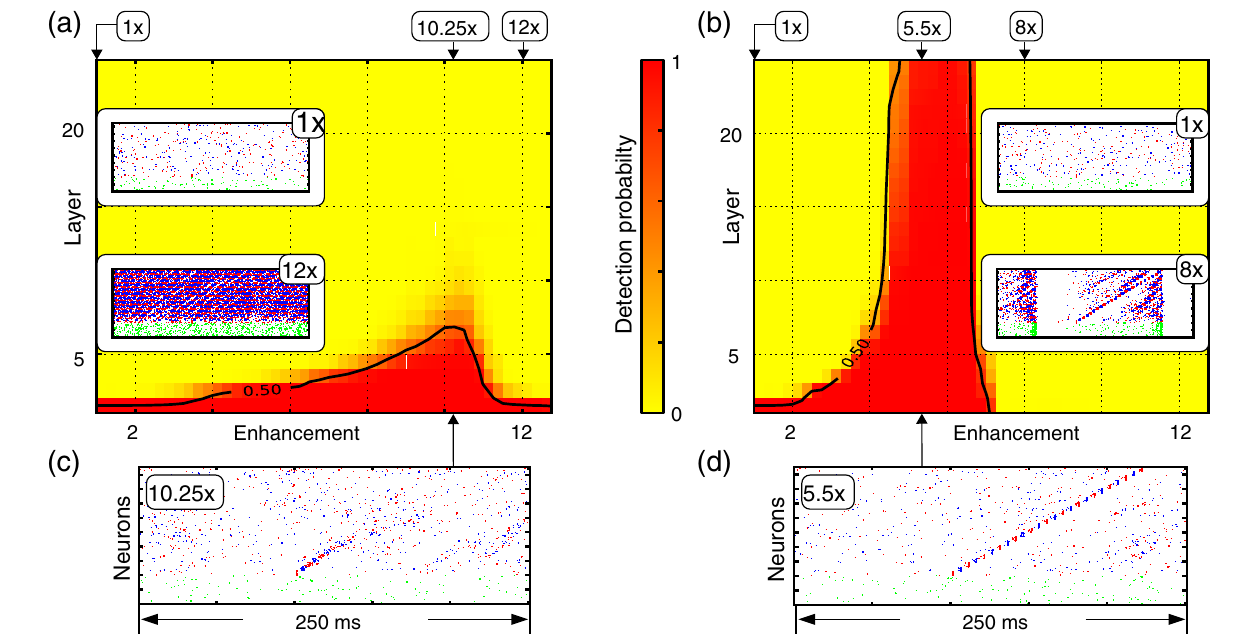
FIG. 4. Nonlinear dendritic interactions enable guided propagation of synchrony in random networks ( N ¼ 10 000 , p ¼ 0 : 03 , ! ¼ 30 ). (a),(b) Detection probability of induced synchronous activity in (a) conventional networks and (b) in networks with nonlinear dendrites. Insets of (a),(b) and Figs. (c),(d)_Typical examples of network activity for different synaptic-enhancement factors. Red and blue indicate spikes of neurons within the FFN; green indicates spikes of neurons randomly sampled from the remaining